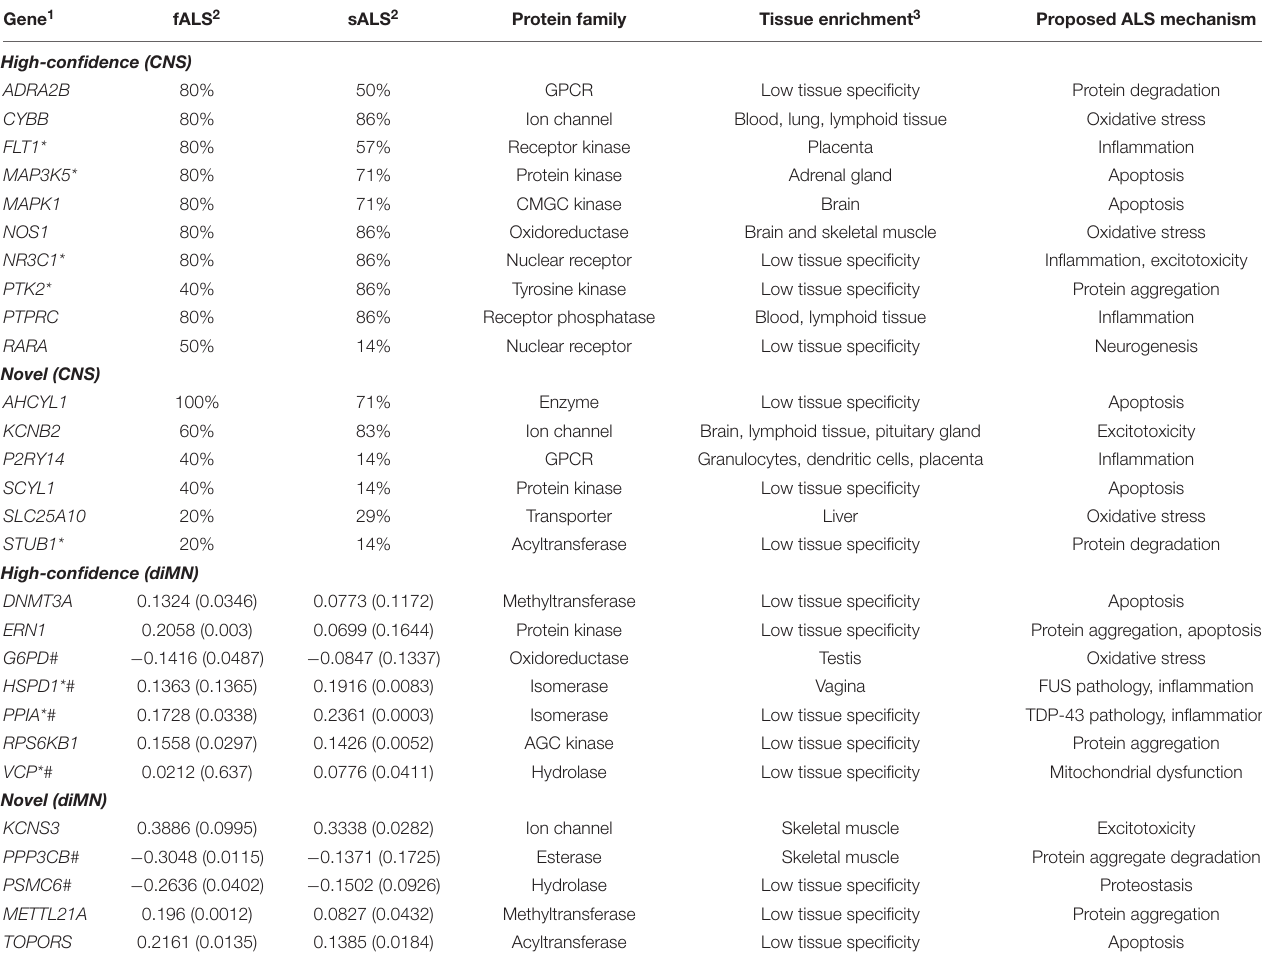
TABLE 2 | List of potential therapeutic